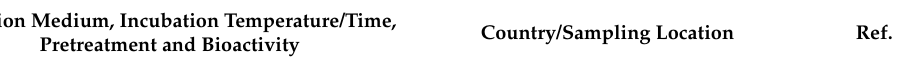
Coral Species and Nature of Isolation Medium, Incubation Temperature/Time, Sample Pretreatment and Bioactivity